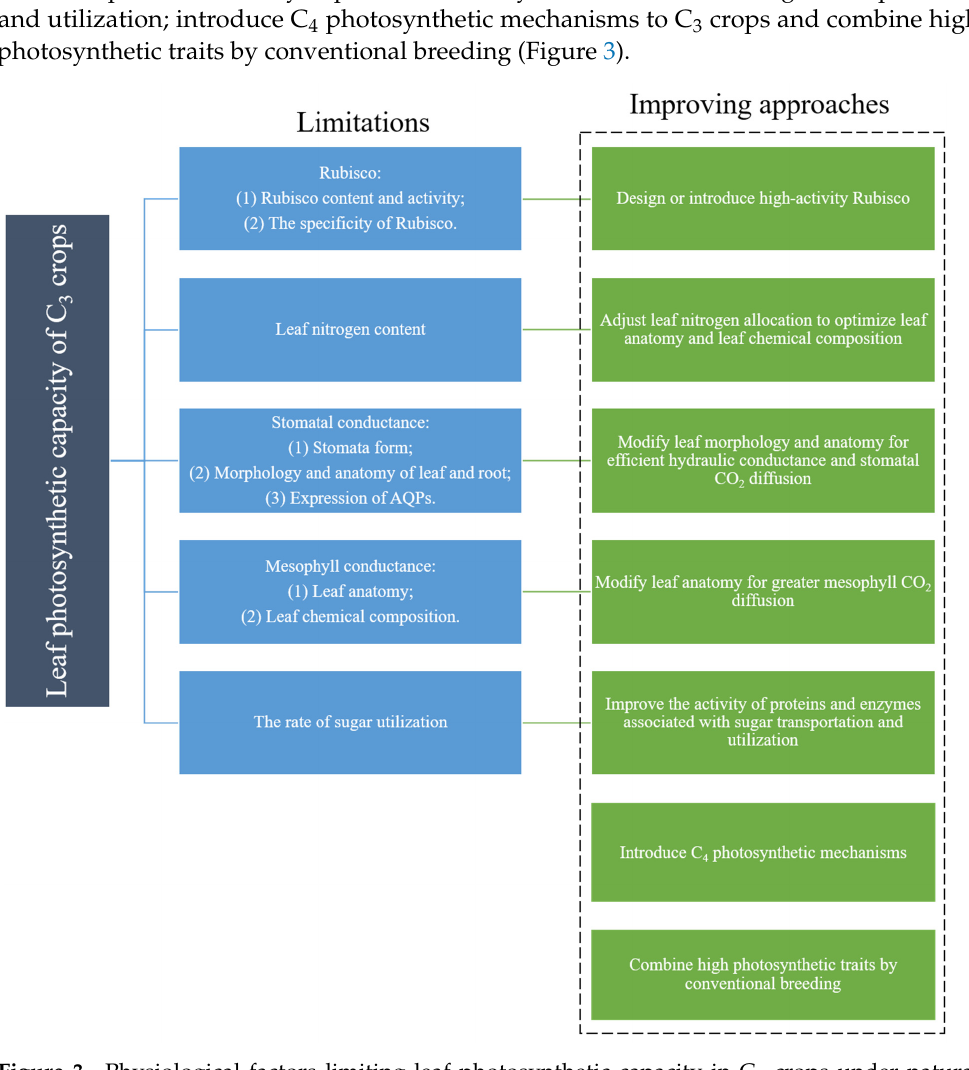
Figure 3. Physiological factors limiting leaf photosynthetic capacity in C 3 crops under natural conditions and approaches for improving it.